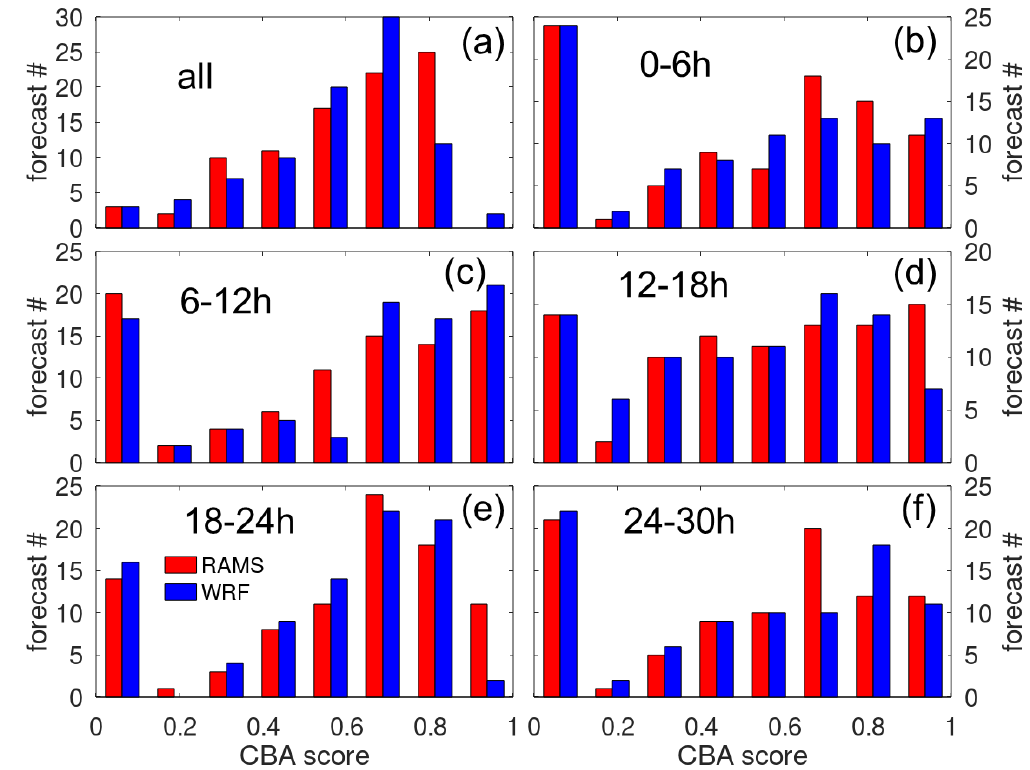
Figure 6. Histograms of RAMS and WRF CBA forecast scores using RMSE (bin size 0.125 and number of forecasts per bin on the ordinate). ( a ) Scores for 30 h forecasts; ( b ) scores for 0–6 h forecasts; ( c ) scores for 6–12 h forecasts; ( d ) scores for 12–18 h forecasts; ( e ) scores for 18–24 h forecasts; and ( f ) scores for 24–30 h forecasts. Lower scores are better. Table 3. Mean and standard deviation of forecast scores for the full forecast (All) and for each 6 h forecast period. Scores for CBA and CF for each model. CBAo are scores calculated only for times when CBA existed for both the model and ceilometer.